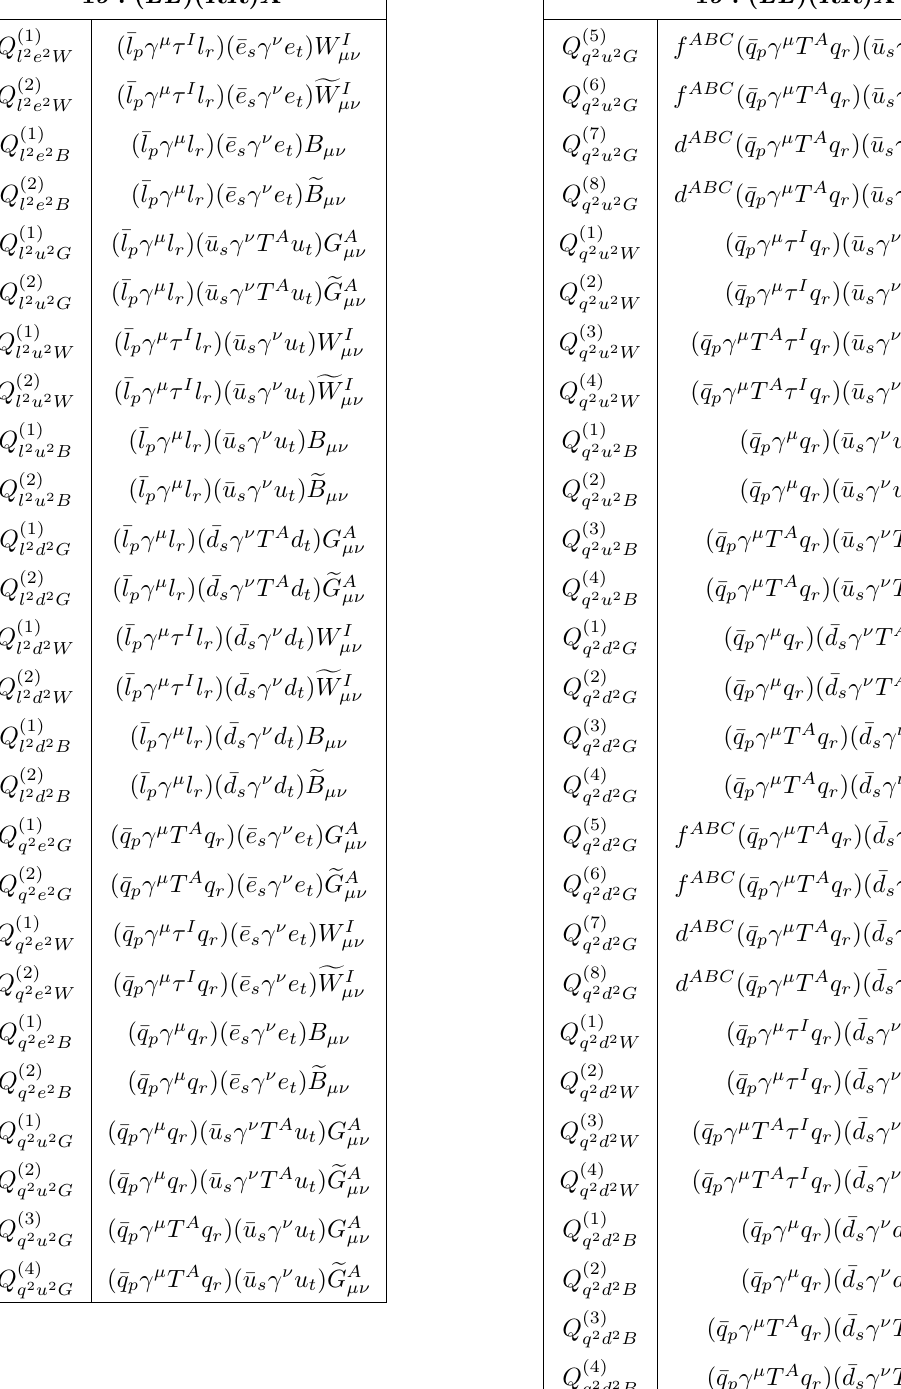
Table 13 . The dimension-eight operators in the SMEFT of class-19 with (cid:12)eld content ((cid:22) LL )( (cid:22) RR ) X . The subscripts p; r; s; t are weak-eigenstate